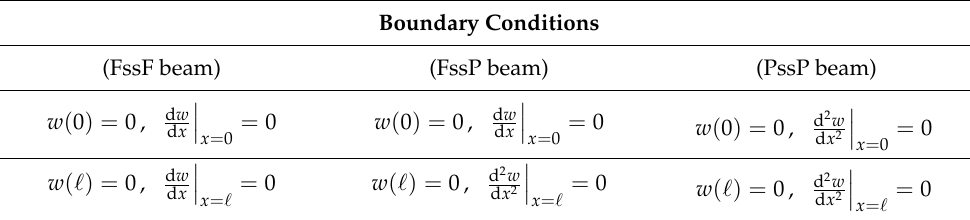
Table 1. Boundary and continuity